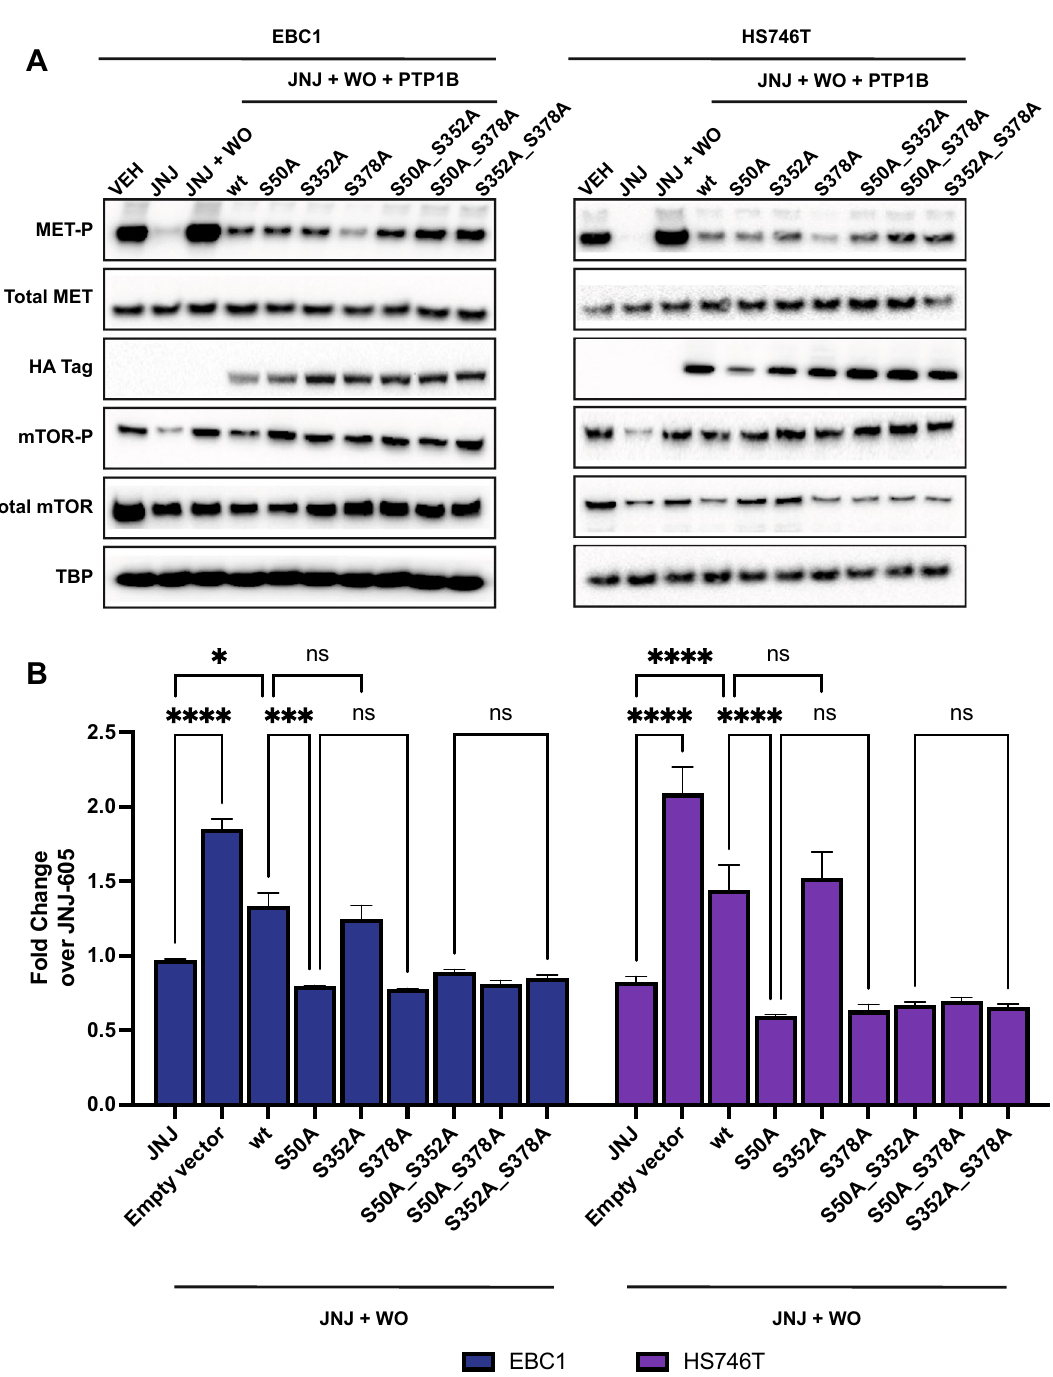
Figure 4. Phosphorylation on S50 and S378 inhibits the activity of PTP1B. ( A ) EBC1 and HS746T cells were treated with DMSO or JNJ-605. After WO, cells were transiently transfected with indicated vectors (JNJ + WO condition corresponds to transfection with an empty vector). All vectors containing the cDNA of PTP1B were N-terminally tagged with HA. Cellular lysates were immunoblotted, as indicated on the left. Black-edged rectangles delineate the blot. ( B ) Cells were treated and transfected as in ( A ) and subjected to viability assay 72 h post-WO and post-transfection. Results are the mean fold change over JNJ-605-treated cells without WO +/− SEM with N = 6. ANOVA was performed to test statistical significance with Tukey’s post-hoc test with ns: not significant; * P < 0.05; ** P < 0.01; *** P < 1.10 –3 ; **** P < 1.10 –4